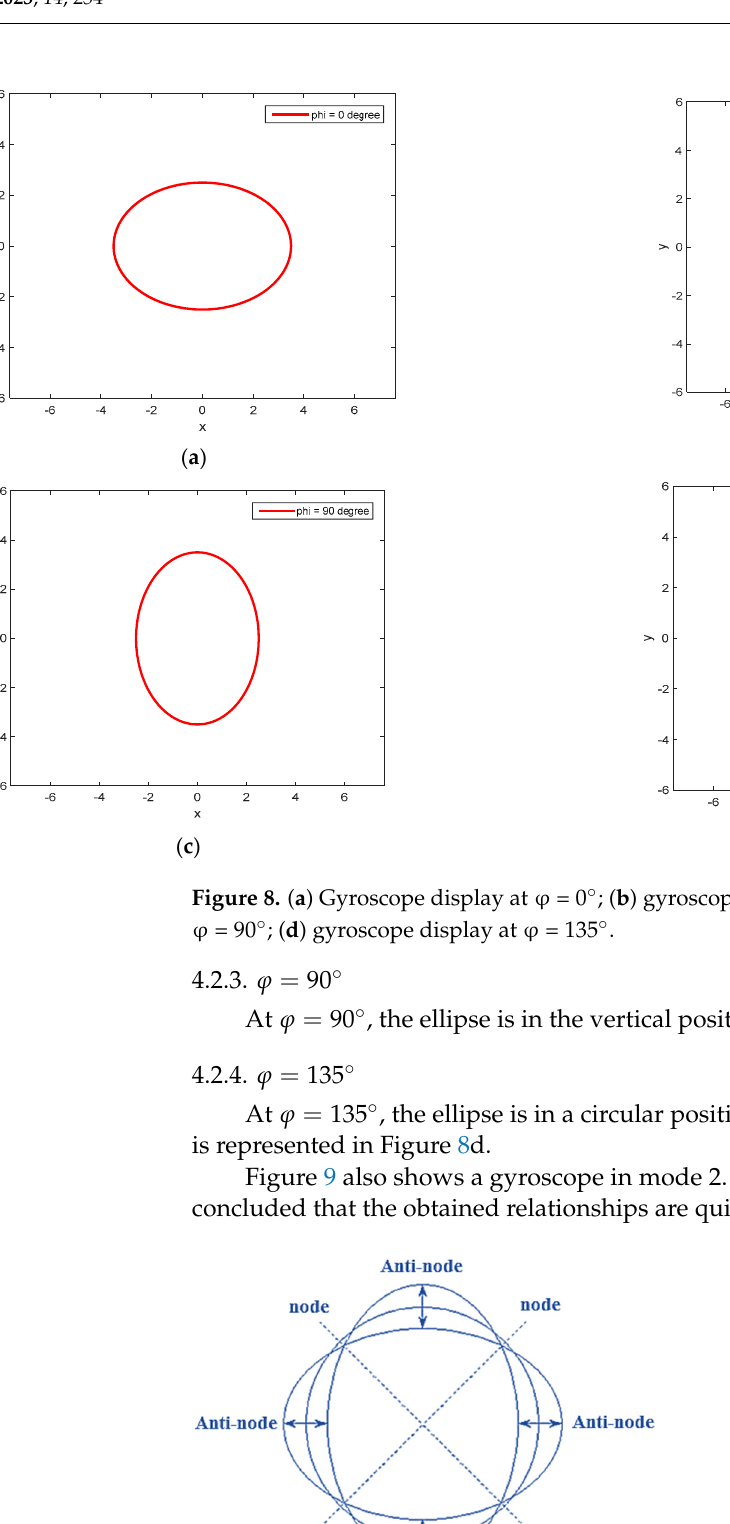
Figure 9. Gyroscope changing in nodes and anti-nodes in the second mode.